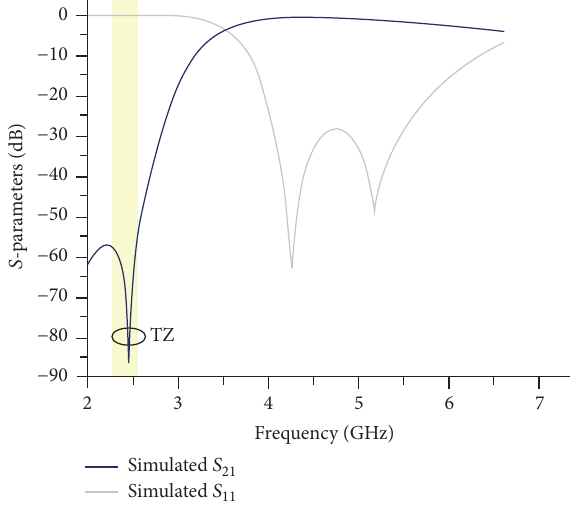
Figure 5: The simulated 𝑆 -parameters of the dumbbell